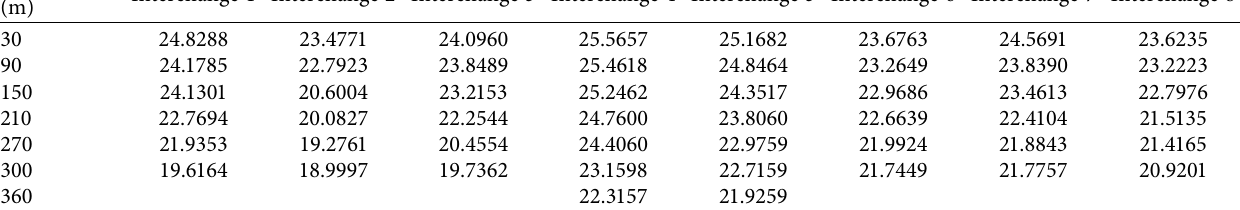
Table 7: LST diffusion for eight interchanges’ areas in 2018.